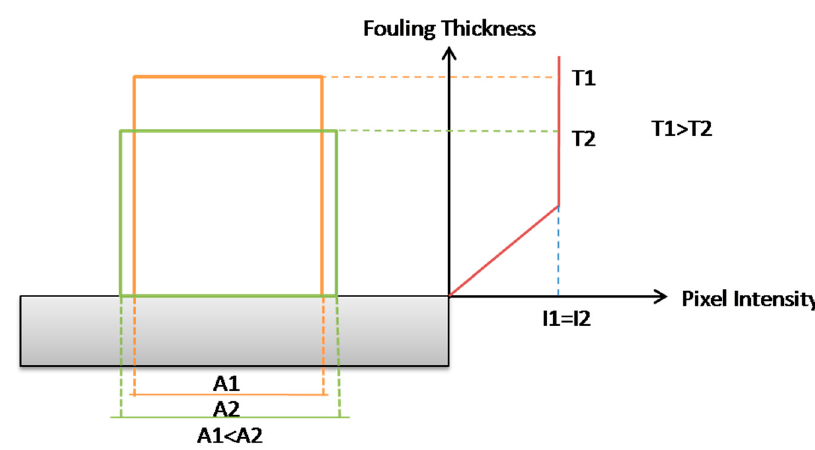
Figure 14. Fouling volume indicator chart.